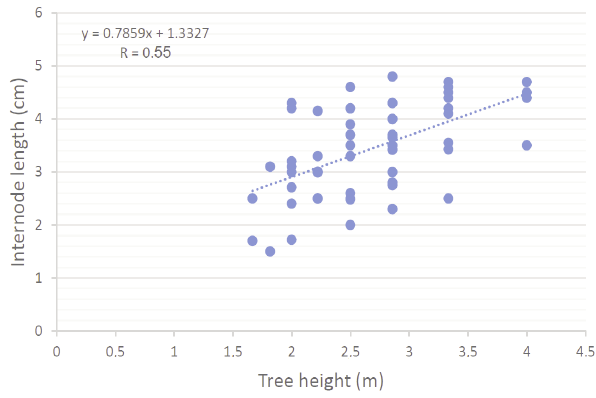
Fig. 3 ­ Pearson’s correlation coefficients between internode length and tree height in 19 Iranian pomegranate culti­ vars.